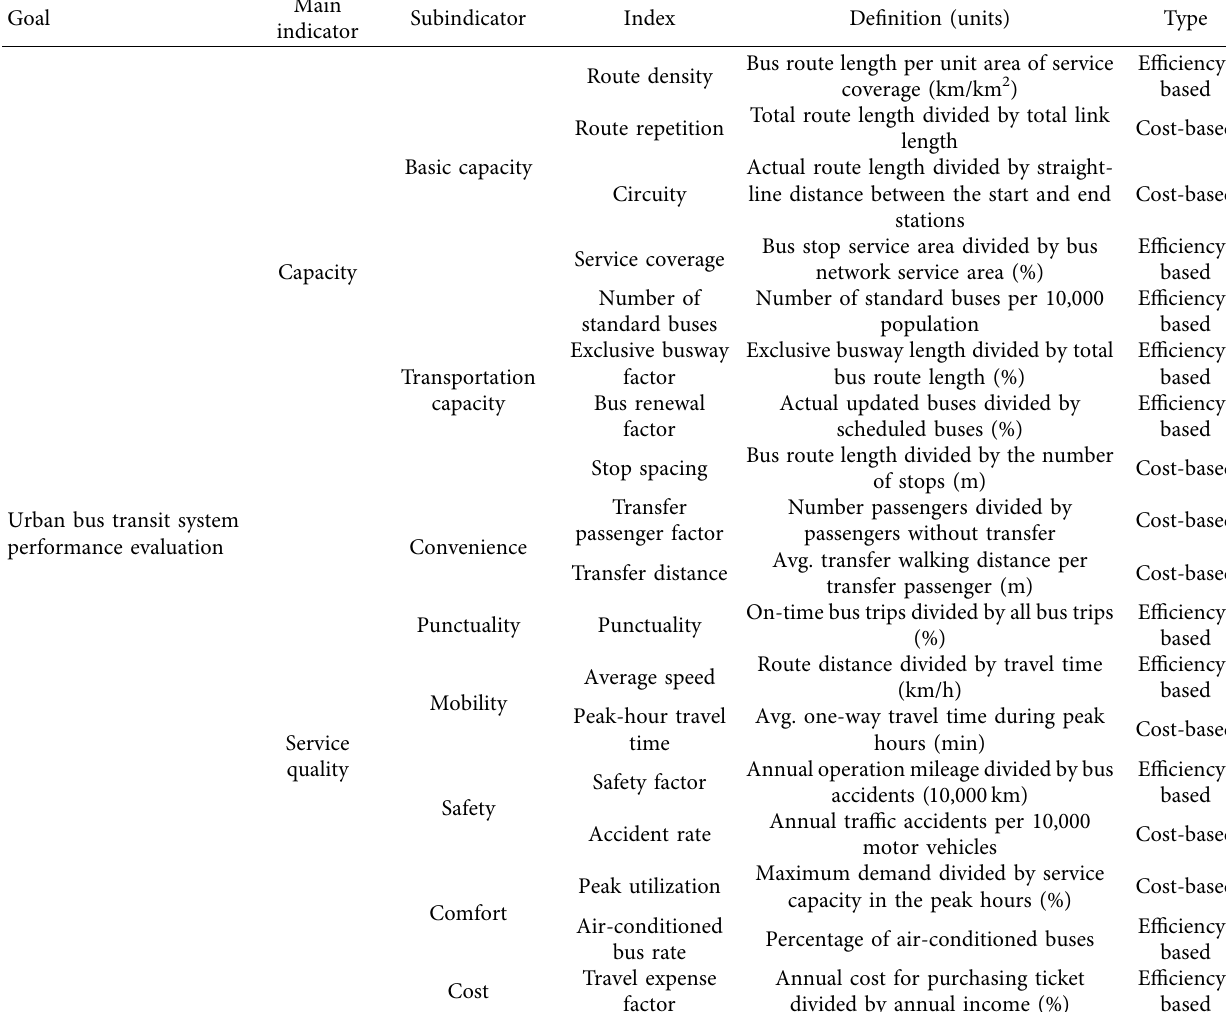
Table 2: Evaluation indices and definitions of bus transit.